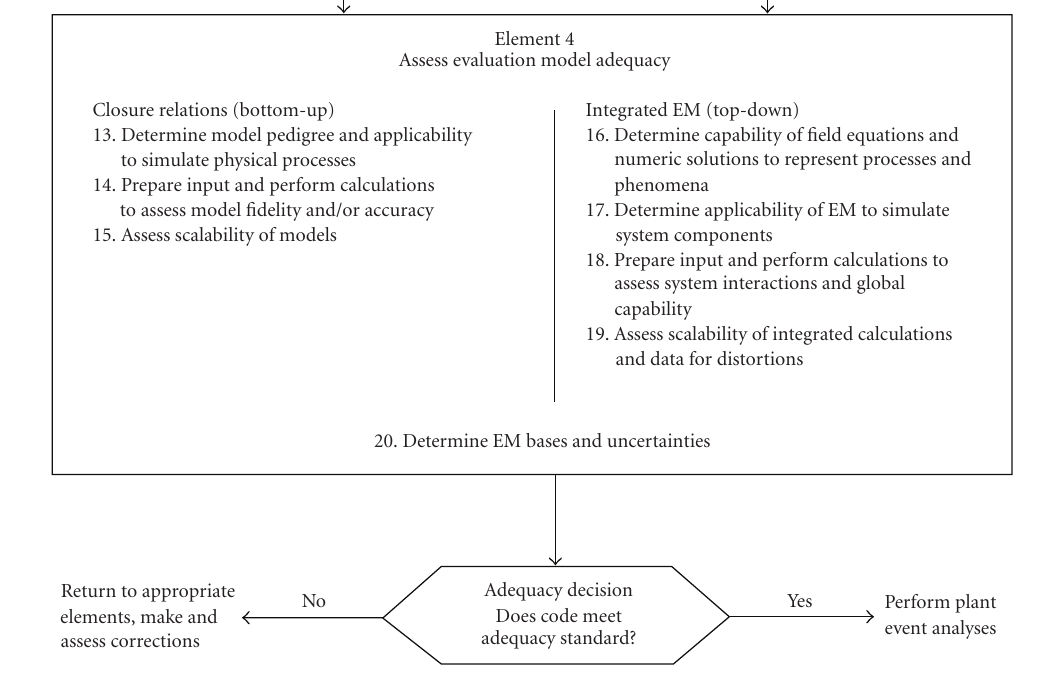
Figure 1: EMDAP (Reg. Guide